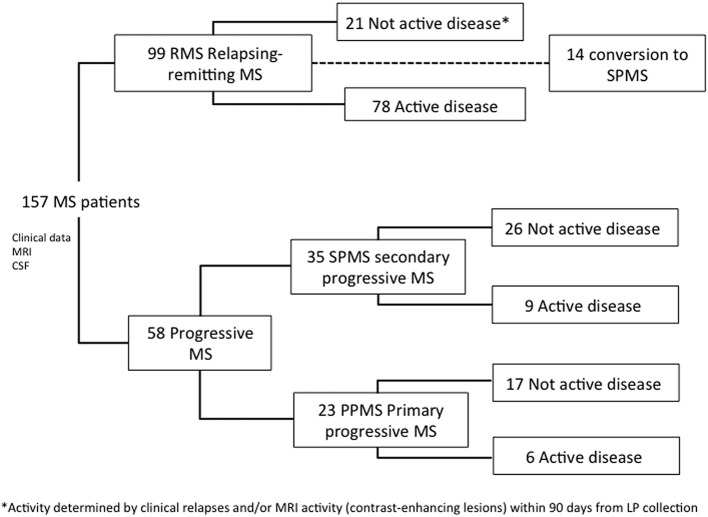
Flow chart of study cohort.